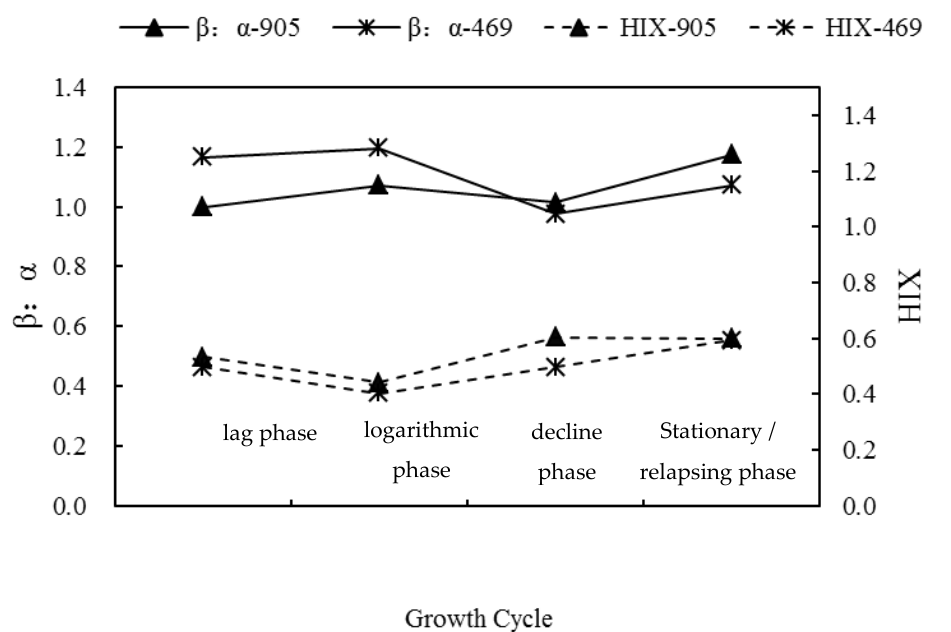
ff erent stages of